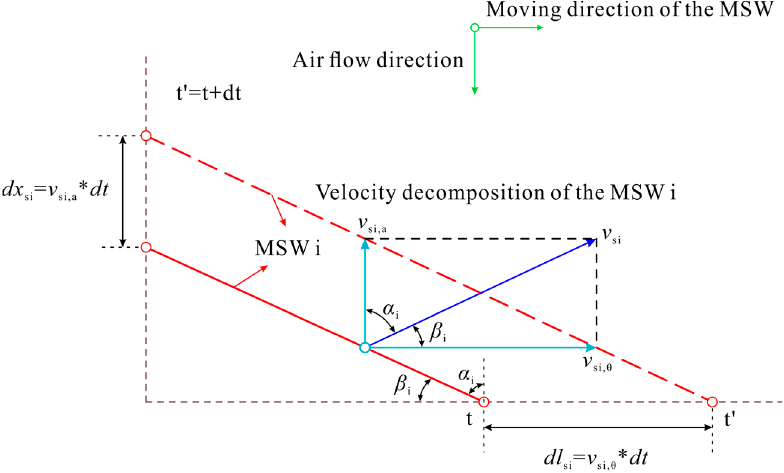
Figure 21. Sketch of MSW i.